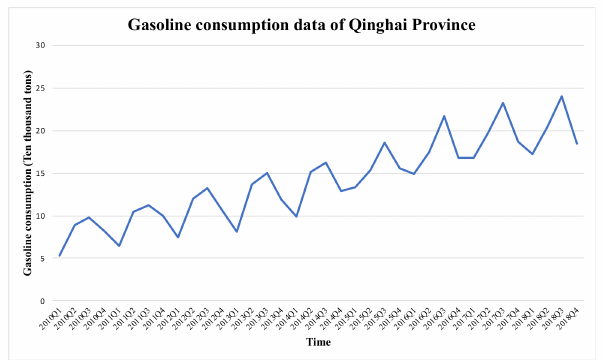
Figure 2. Gasoline consumption data of Qinghai Province.